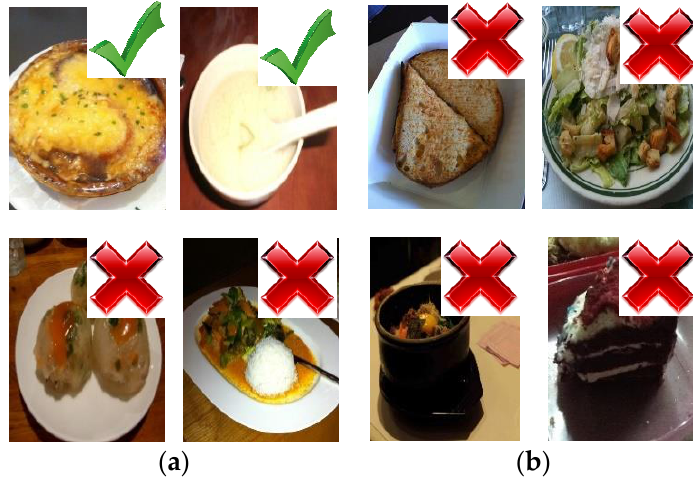
Figure 8. Some sample images from the Food-101 dataset. ( a ) These four images are selected to build the SSNet representation using the Dense SIFT features. ( b ) These four images are selected to build the SSNet representation using the CNN local features. The check mark indicates that this image can be recognized correctly by our proposed method, and the cross indicates that our method cannot recognize this image correctly.